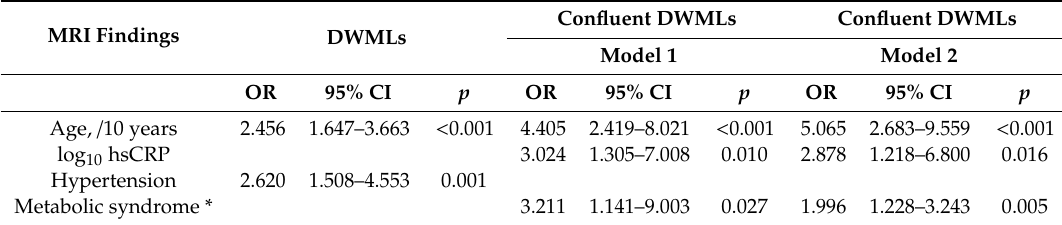
Table 2. Potential Risk Factors for Deep White Matter Lesions (DWMLs).